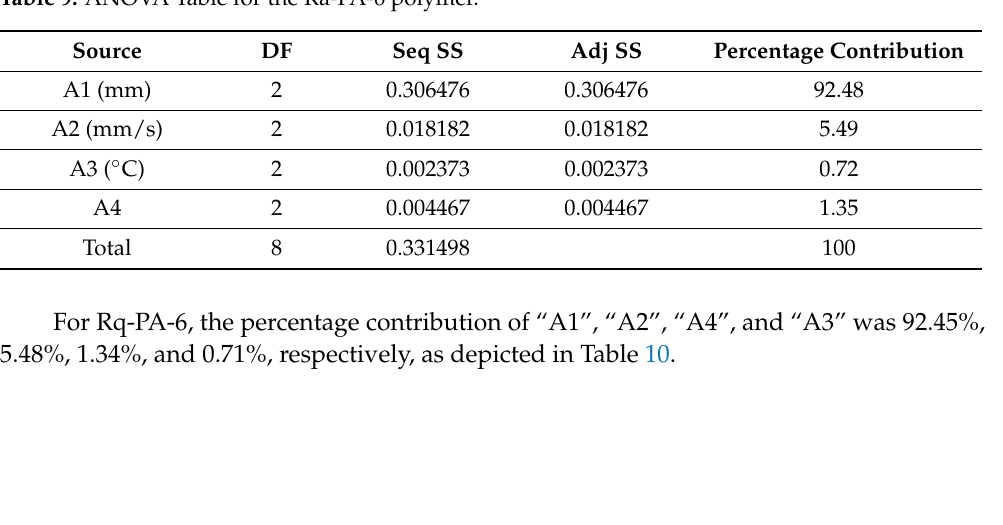
Table 9. ANOVA Table for the Ra-PA-6